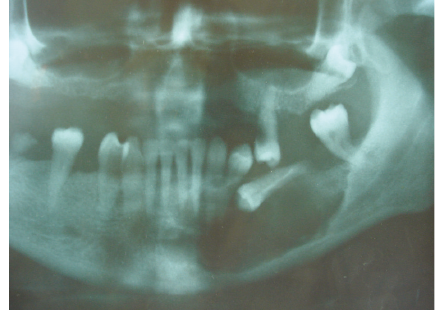
Figure 8: A detail from the OPG showing an impacted 35 and clearly lined RTG radiolucency in the region of 33-37 when compared to the other parts of the